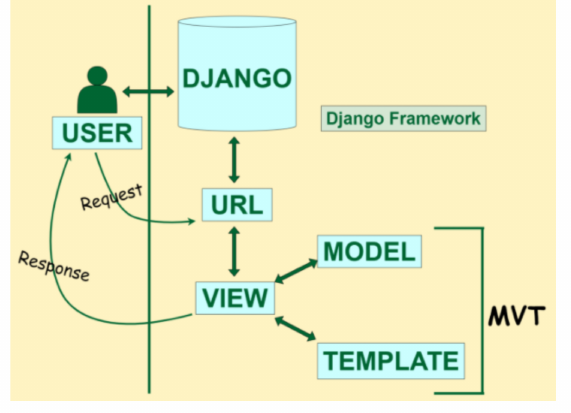
Figure 5. MVT structure of a Django